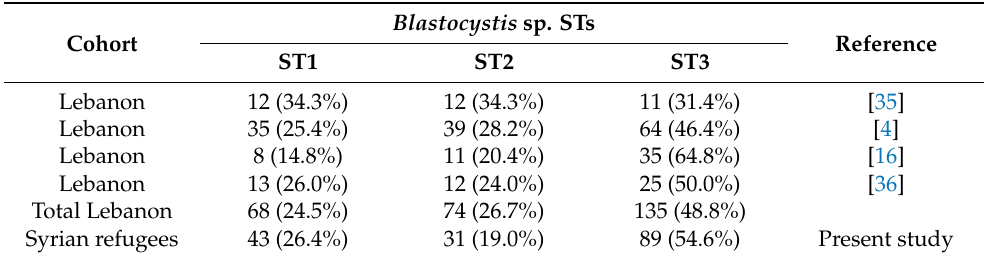
Table 2. Distribution and percentages of ST1, ST2 and ST3 isolates among the Lebanese population living in North Lebanon region and the Syrian refugee